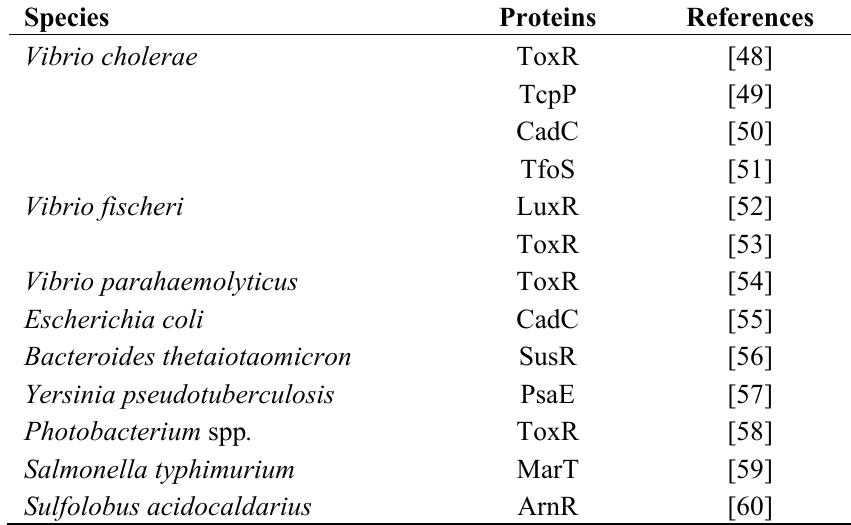
Table 2. Membrane-localized transcription activators have been identified in several different bacterial species, as enumerated below. Membrane-localized transcription has also been observed in the archaea Sulfolobus acidocaldarius